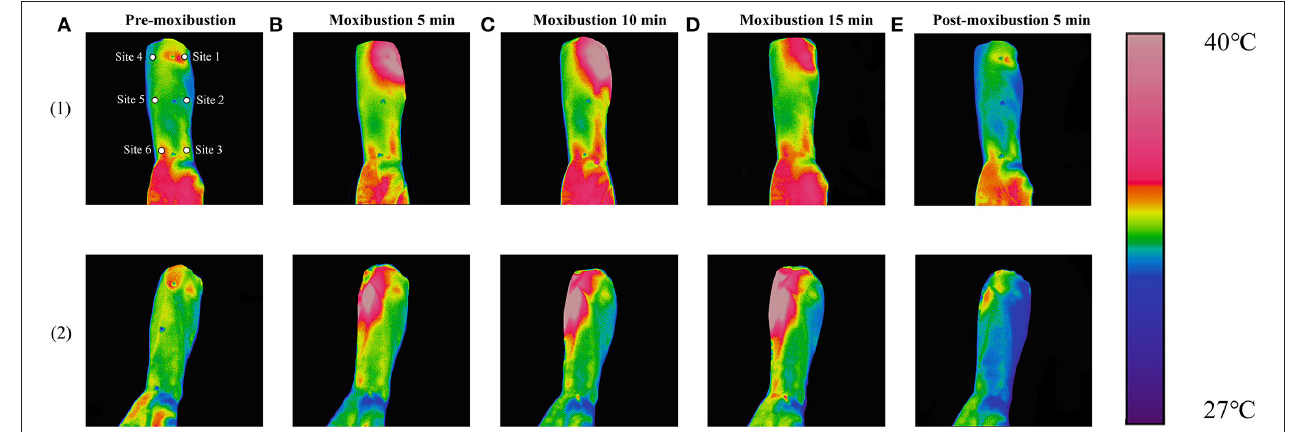
FIGURE 6 | Continuous display of representative infrared images. (1) Infrared images in the lung intervention group and (2) Infrared images in the heart intervention group. (A) images with pre-moxibustion, (B) images with moxibustion 5min, (C) images with moxibustion 10min, (D) images with moxibustion 15min, and (E) Images with post-moxibustion